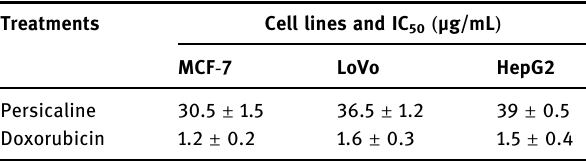
Table 1: IC 50 values of persicaline in di ff erent cancer cells